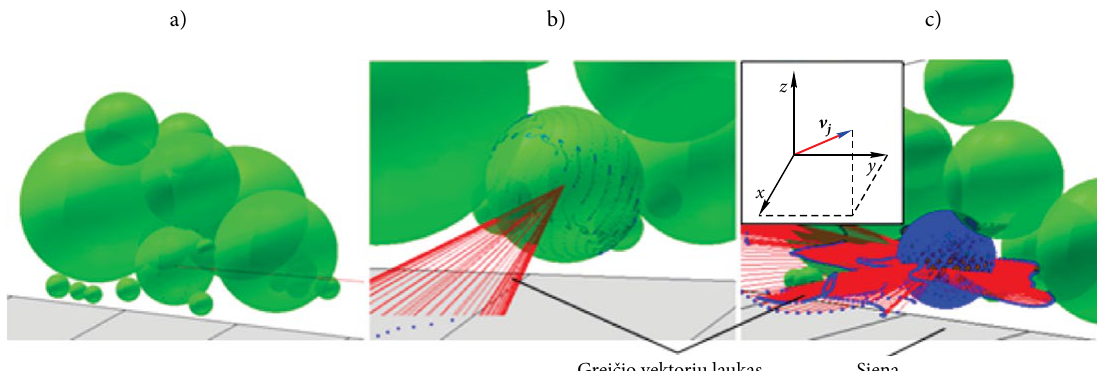
Fig. 4. Development of the field of the i th particle’s velocity vectors in the constrained environment: a – the first velocity vector (red) and it’s normal plane (the blue circle with dotted circumferencecircle); b – partial visualisation of vector fields; c – the full vector field and texture formed on the surface of the particle of the intersection between normal planes